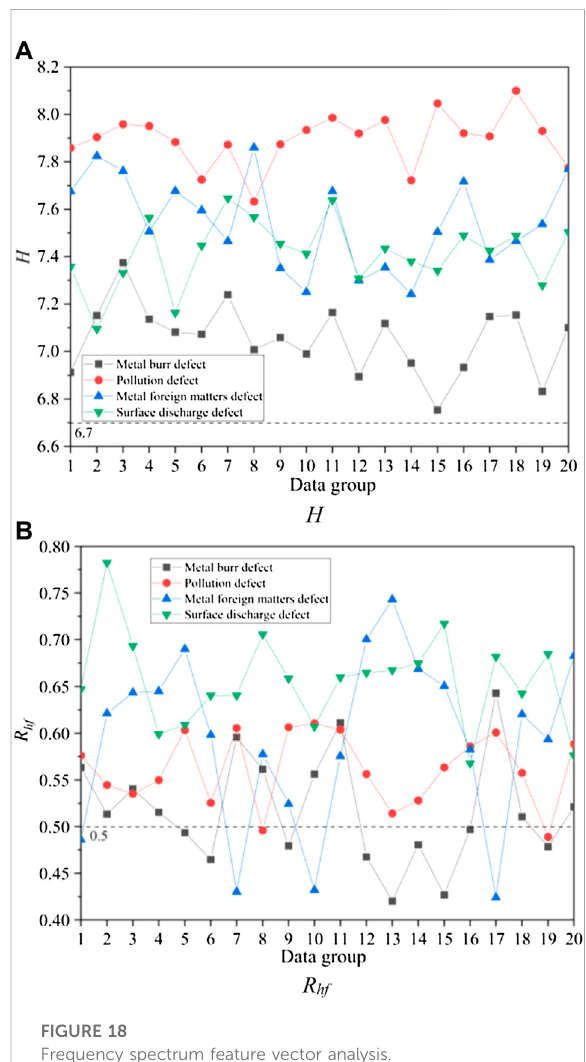
FIGURE 18 Frequency spectrum feature vector